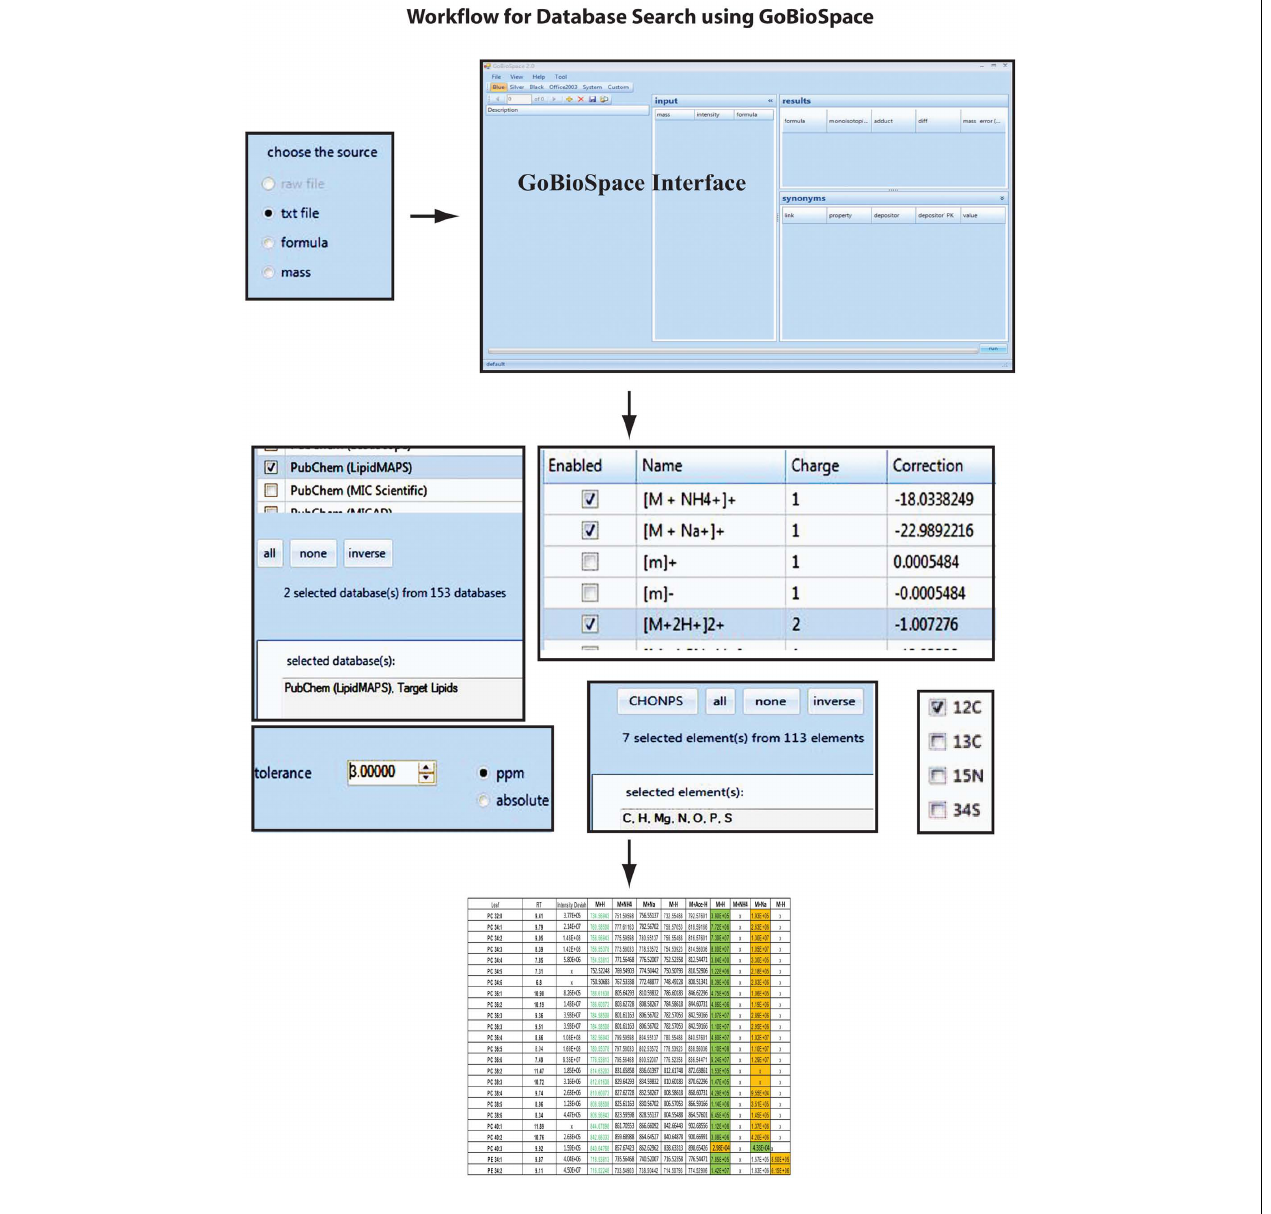
of search criteria (databases, expected mass adducts, mass error tolerance, expected elements, and isotope label), and data